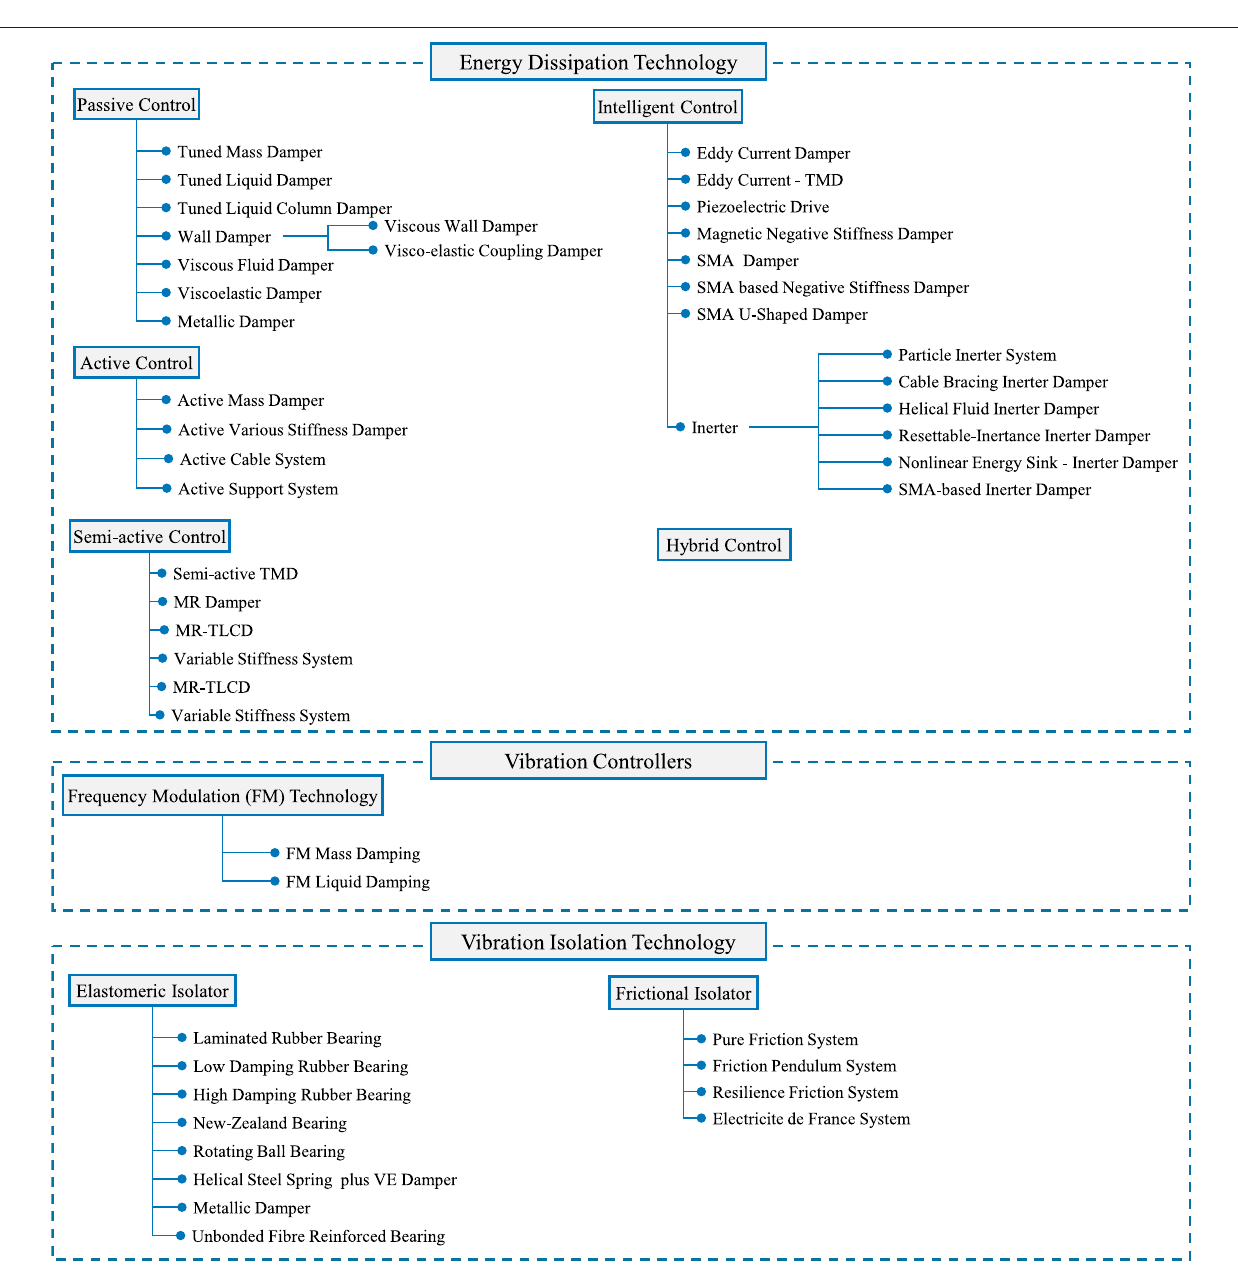
Frontiers in Built Environment |